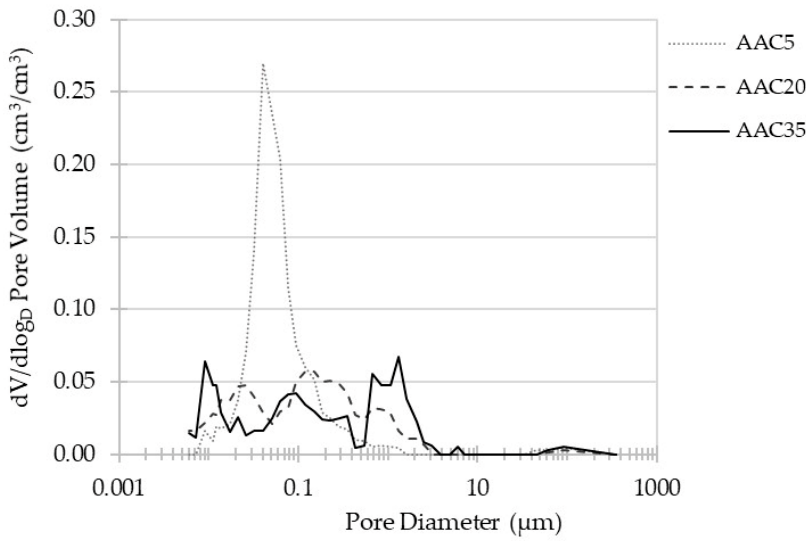
Figure 10. Pore size distribution of alkali-activated concretes.